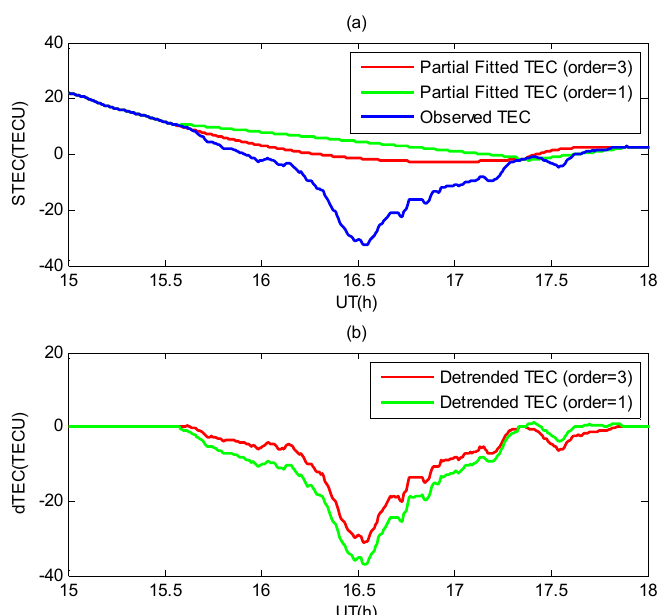
Figure 7. Case of long-duration EPB observed by station HKKT and satellite G09 with first-order and third-order partial polynomial fitting. ( a ) Observed total electron content (TEC, blue line) and partially fitted TEC using first-order (green line) and third-order polynomial (red line); ( b ) detrended TEC by subtracting the partially fitted TEC from the observed TEC (green line for first order and red line for third